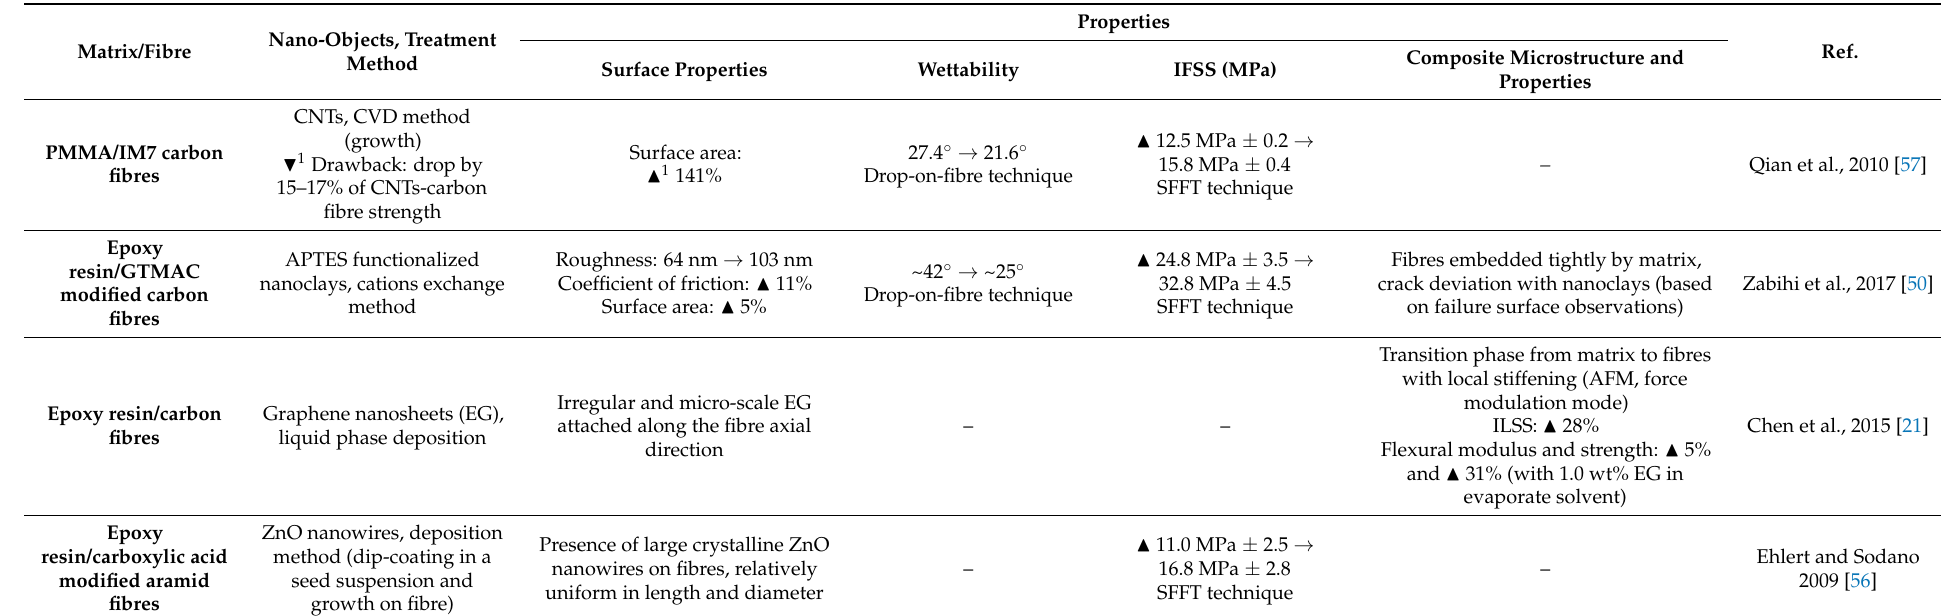
Table 1. Fully synthetic hierarchical composites: characteristics and